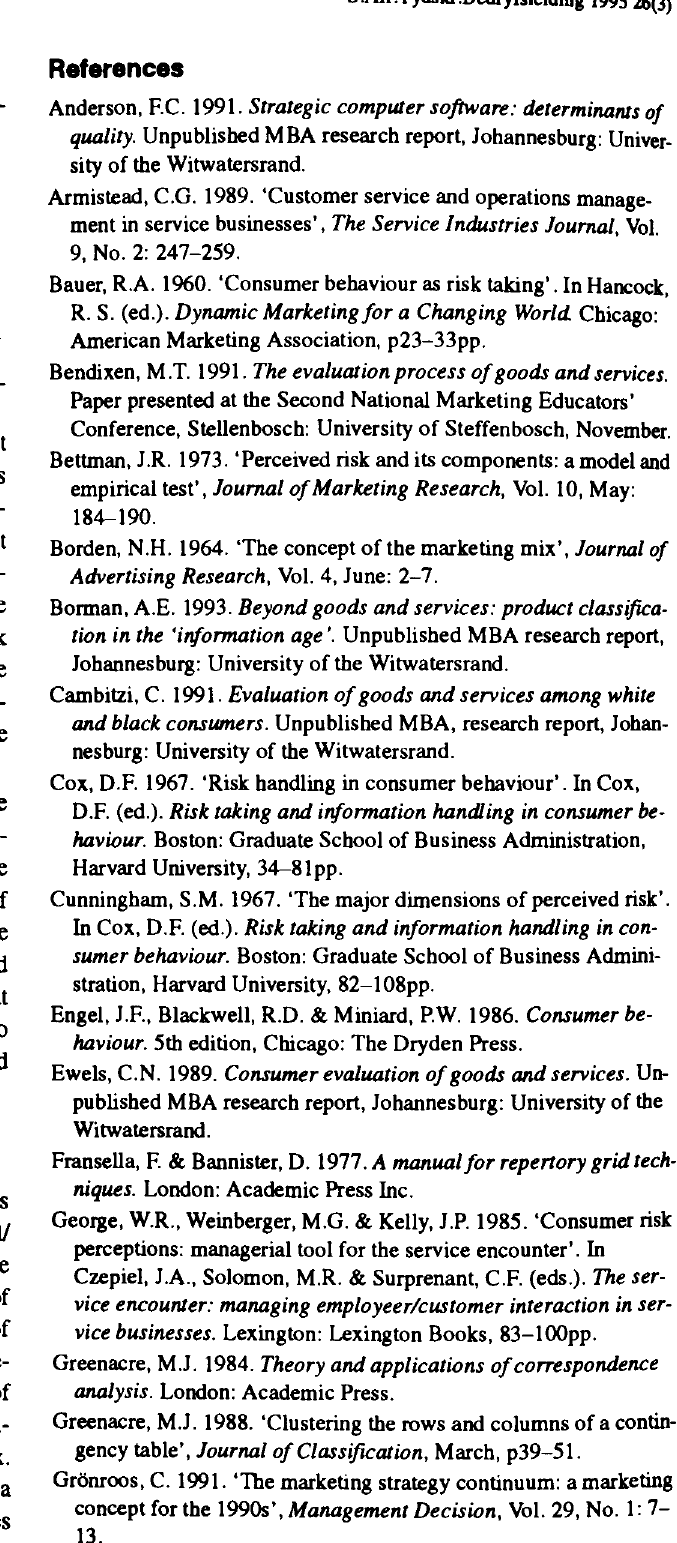
Table 5 Product/risk reduction strategy